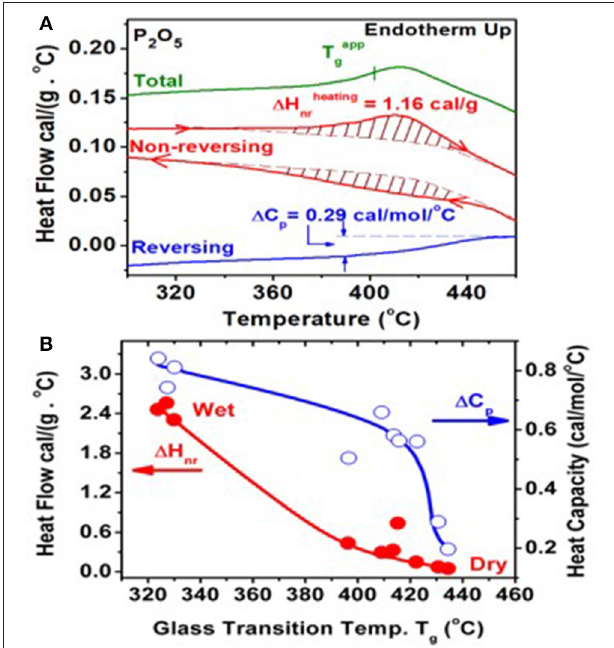
FIGURE 5 | (A) An m-DSC scan of one of the driest P 2 O 5 glass synthesized. The total, reversing, and non-reversing heat flows in the heating up cycles are displayed (B) . A plot of 1 H nr on the left ordinate as a function of T g , and 1 C p on the right ordinate as a function of T g for the 10 samples measured. The glass sample with the highest T g of 435(2) ◦ C is identified with dry P 2 O 5 glass. This particular glass sample has a vanishing 1 H nr ∼ 0, consistent with its isostatically rigid